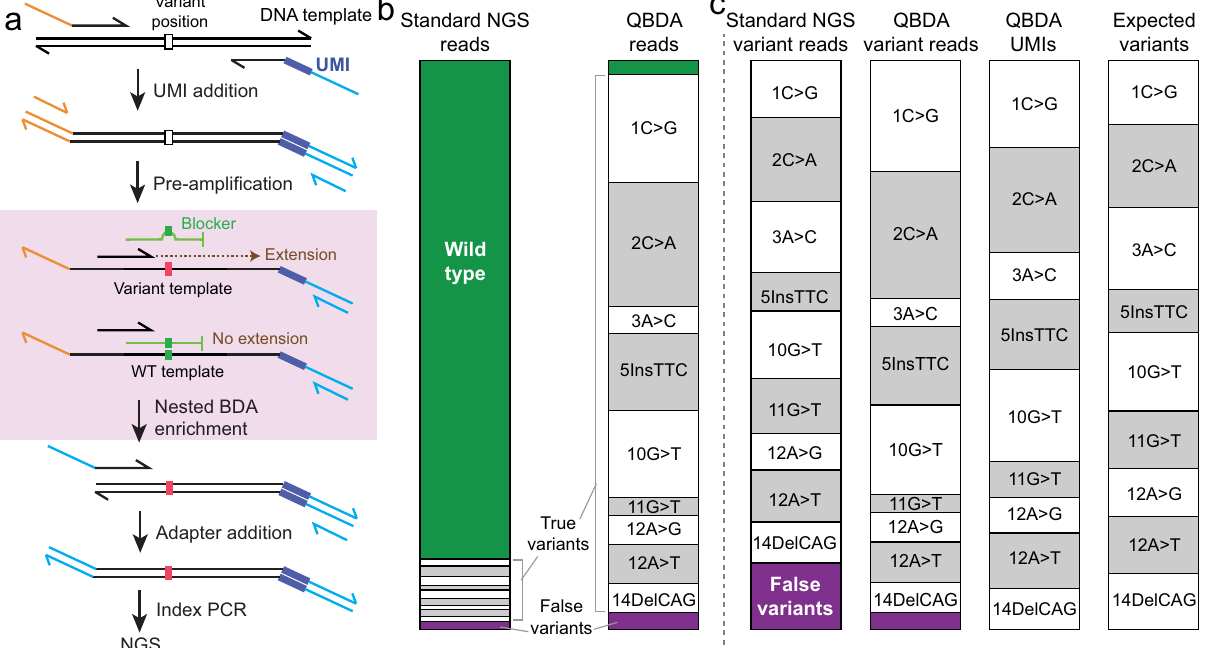
Fig. 1 Quantitative blocker displacement ampli fi cation (QBDA) technology. a QBDA library preparation work fl ow. UMIs are attached to DNA templates by two cycles of PCR, followed by pre-ampli fi cation using universal primers. Next, a nested BDA was performed to enrich variant sequence. The forward primer is closer to the variant position than the primer in the UMI additions step, in order to suppress primer dimer and nonspeci fi c ampli fi cation; an overlapping Blocker suppresses the ampli fi cation of wild-type (WT) templates and allows enrichment of variant templates over many PCR cycles. The NGS adapter is added to the enrichment product, followed by index PCR and sequencing. b Reducing WT reads by QBDA enrichment. WT DNA was mixed with 9 synthetic DNA gBlocks, each containing a different single-base substitution or indel in a 16 nt region, resulting in about 1% variant allele frequency (VAF) for each mutation. Using standard amplicon-based sequencing without enrichment, 88% reads were used for unnecessary repeated sequencing of WT. Using QBDA, all nine mutations were enriched using a single set of primer and Blocker, and the WT reads are suppressed to 2%. c Suppressing error and improving quantitation by UMI in QBDA. Six hundred seventy- fi ve types of false-positive (non-expected) variants were observed in standard NGS in ( b ), occupying 12% of all variant reads, or 1.5% of total reads. All the false variants were removed using UMI-based error correction in QBDA. The observed molecule count for all spike-in variants was within twofold of the expected